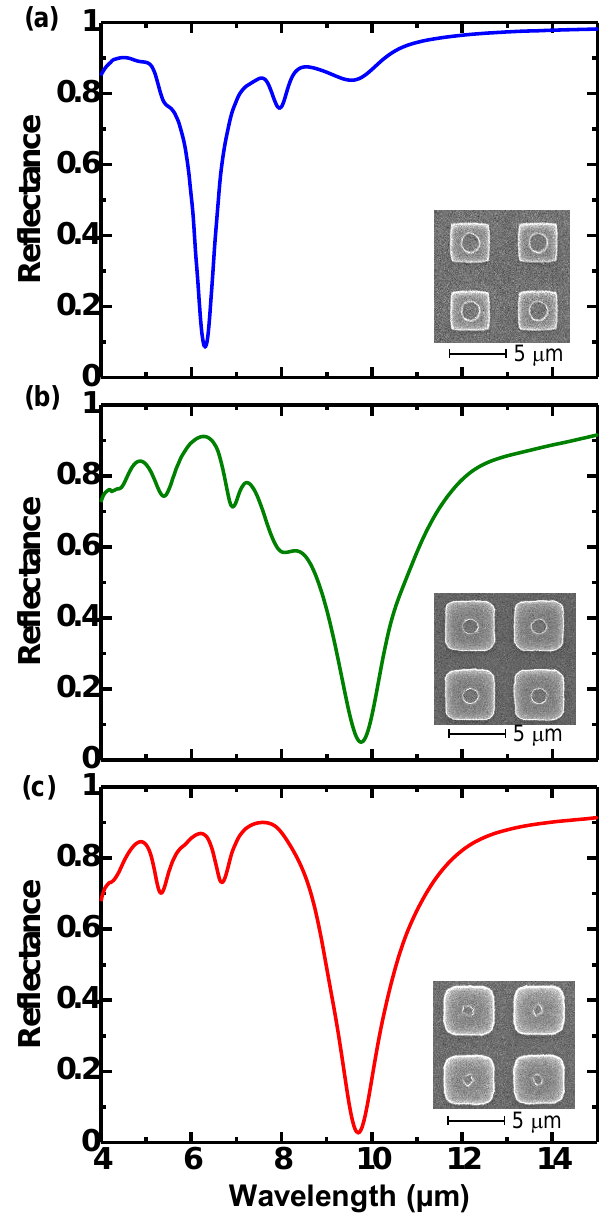
Figure 5. Experimental reflectance spectra for devices with w m and w h of ( a ) 3.5 and 1.5 μm; ( b ) 4.5 and 1.3 μm; and ( c ) 4.3 and 0.7 μm.